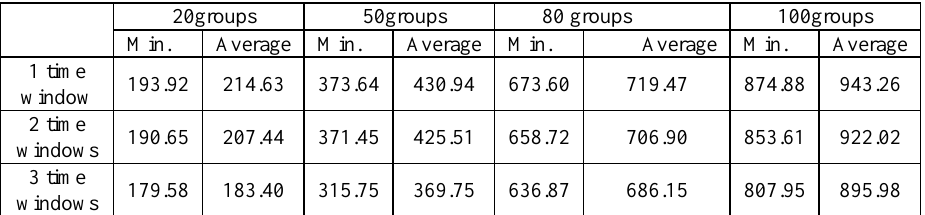
Table 1. Algorithm 4.1 Experimental results.